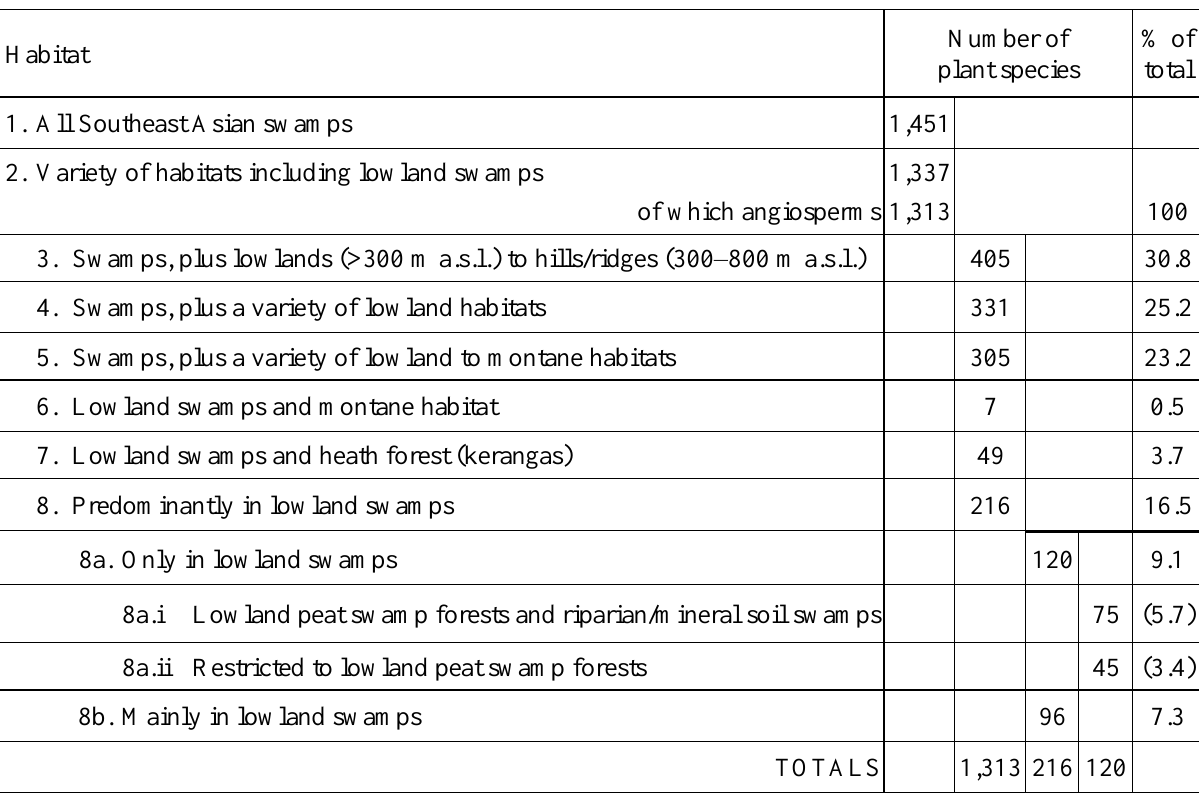
Table 1. Swamp plant species in Southeast Asia: overlap with other habitats.